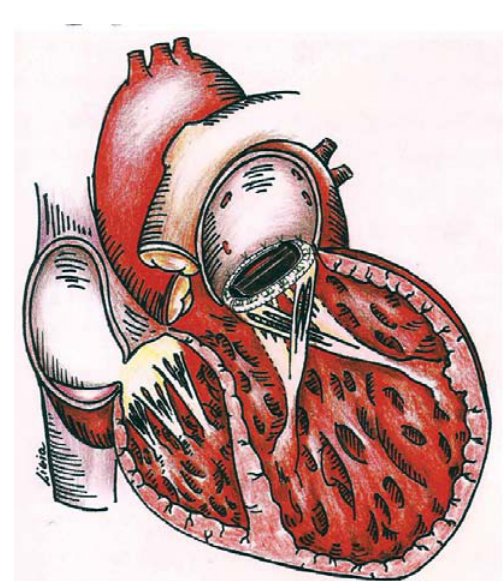
Tabela 2. Média dos parâmetros ecoDopplercardiográficos no pré